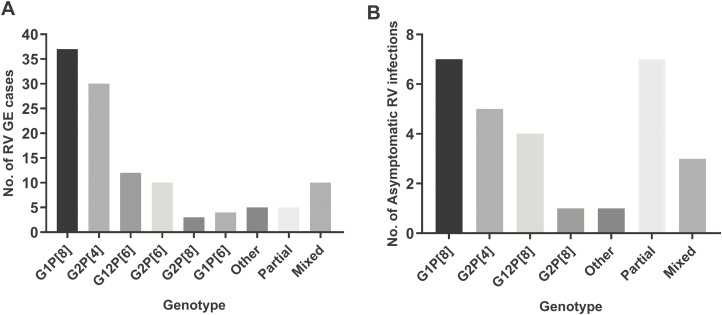
Common genotypes in rotavirus gastroenteritis (RVGE) cases and asymptomatic infection. A, Common genotypes in RVGE cases. B, Common genotypes in asymptomatic RV infection. Partial genotypes: P or G type only confirmed. Mixed infection: more than 1 G or P type identified. Abbreviation: RV, rotavirus; RVGE, rotavirus gastroenteritis.